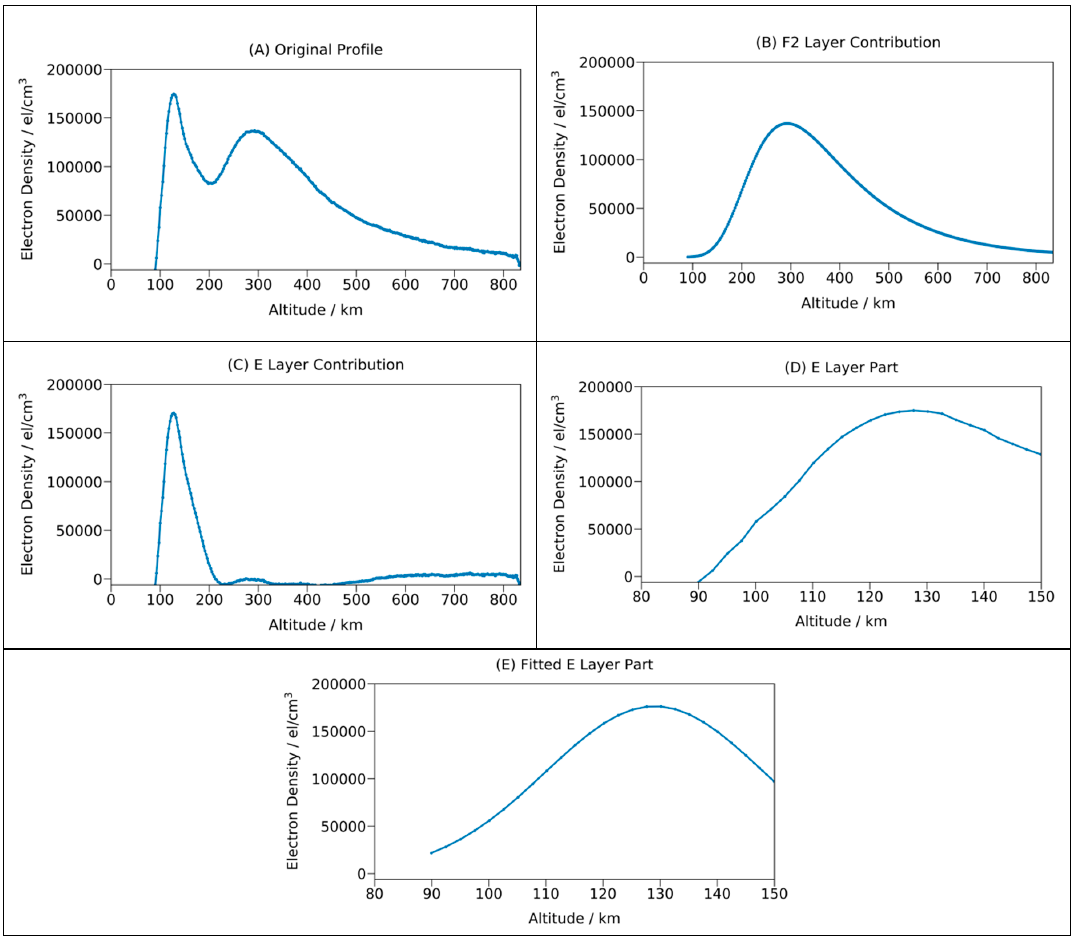
Figure 2. Steps of the E layer fitting process shown for a sample COSMIC profile. Profile date: 09 February 2016; time: 19:41:32; location: 73.3°N, 158.4°E.